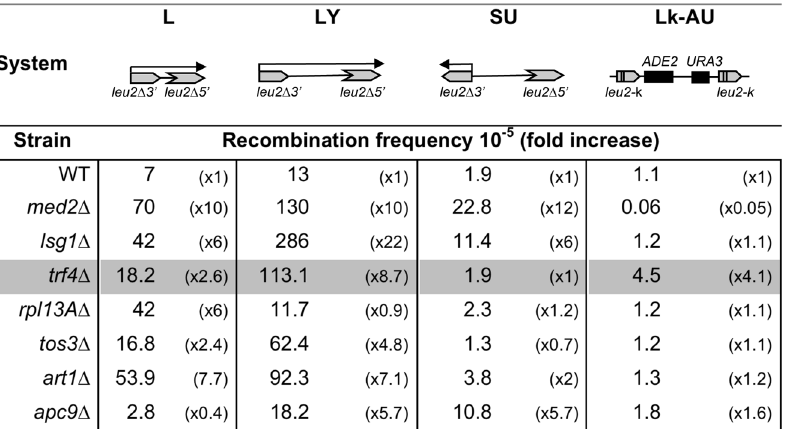
Strain Genotype Source/Reference